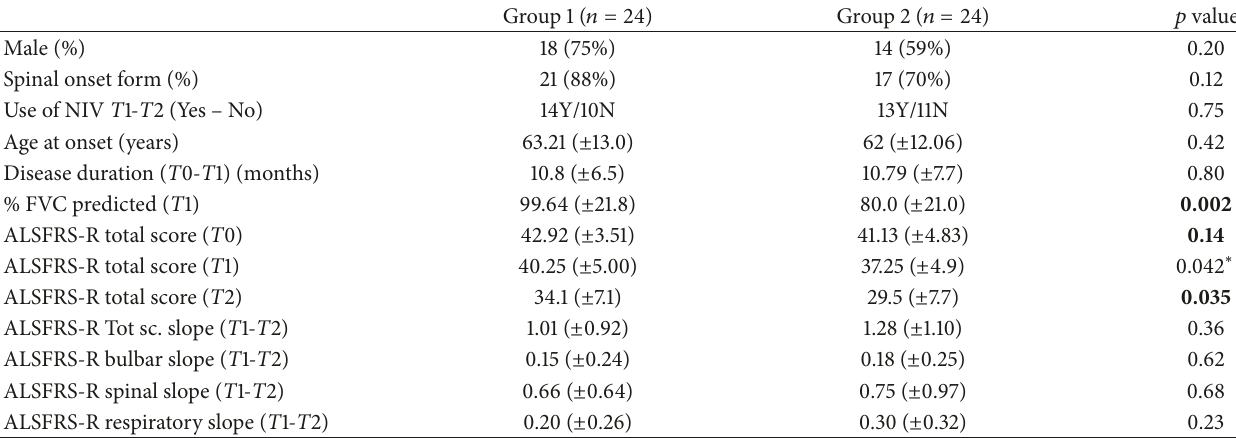
Table 2: Clinical and demographic characteristics of the ALS patients at diagnosis ( T 0), admission to the study protocol ( T 1), and the end of study ( T 2). 𝑇 -Test: mean and standard deviation values for both groups.